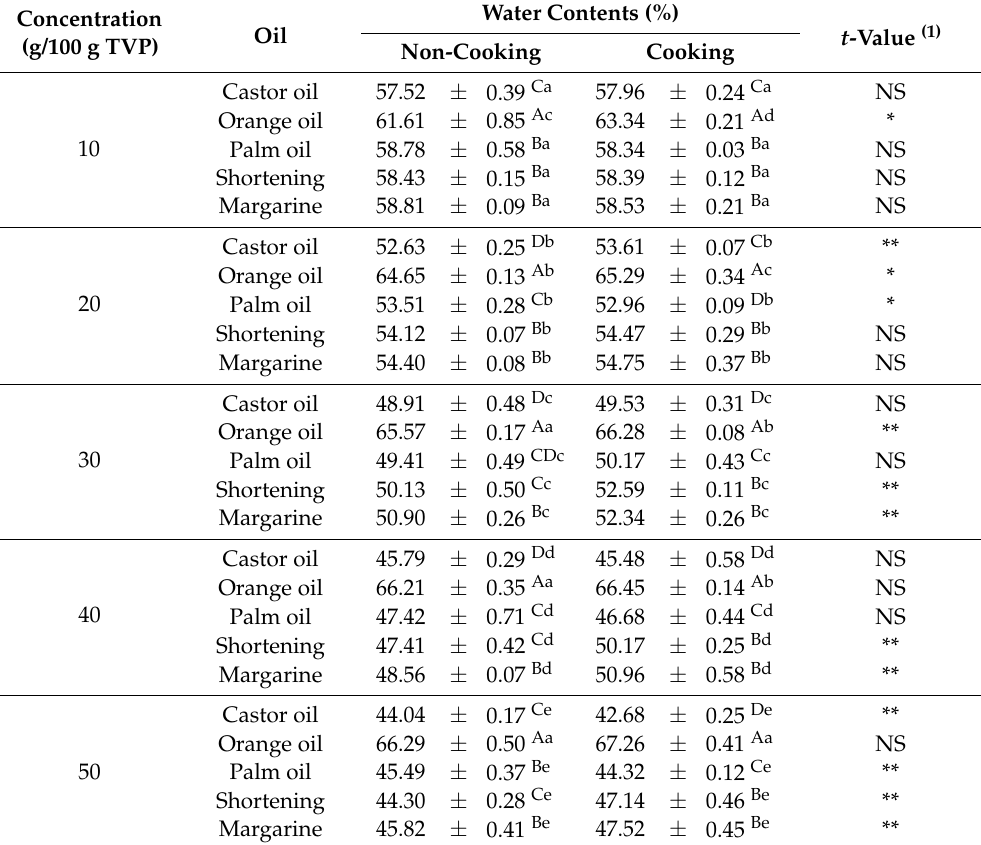
Table 3. Water contents (%) of meat analog supplemented with different types or amounts of vegetable